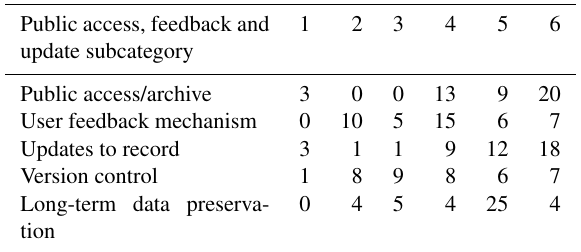
Table 5. Frequency of occurrence of the maturity matrix scores for the five subcategories (public access/archive, user feedback mecha- nism, updates to records, version control and long-term data preser- vation) of the main category – public access, feedback and update.